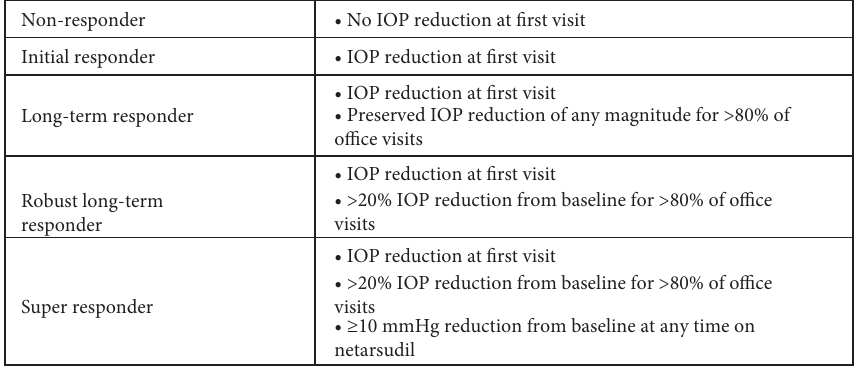
Figure 1: Flowchart defning the diferent classifcations of netarsudil responses.